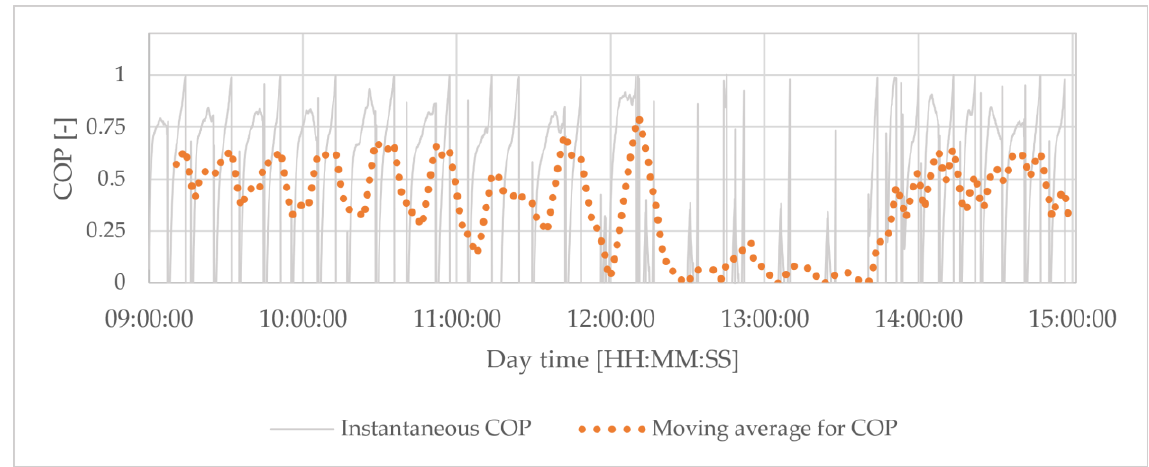
Figure 11. COP values over time for 8th July.